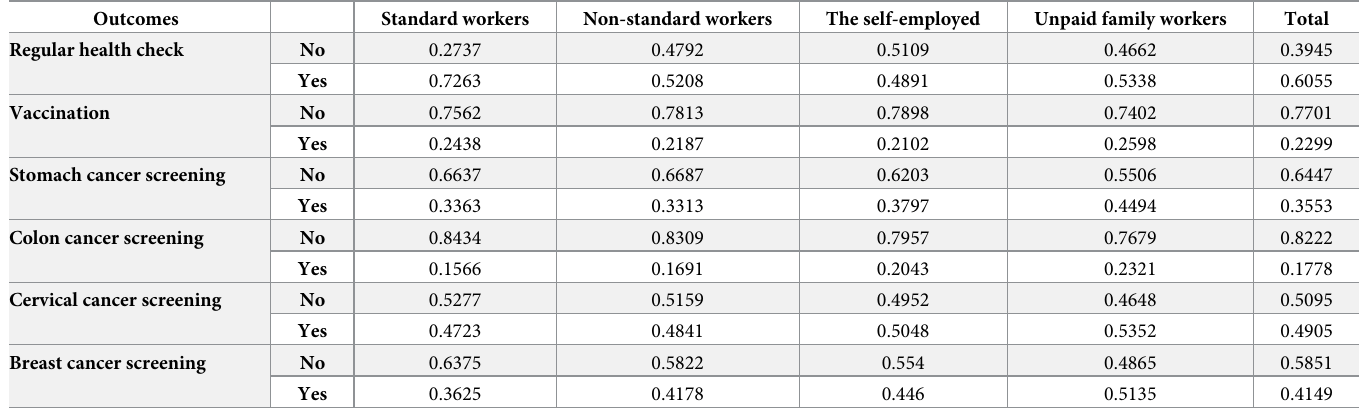
Table 3. Utilization proportions of preventive health services by employment